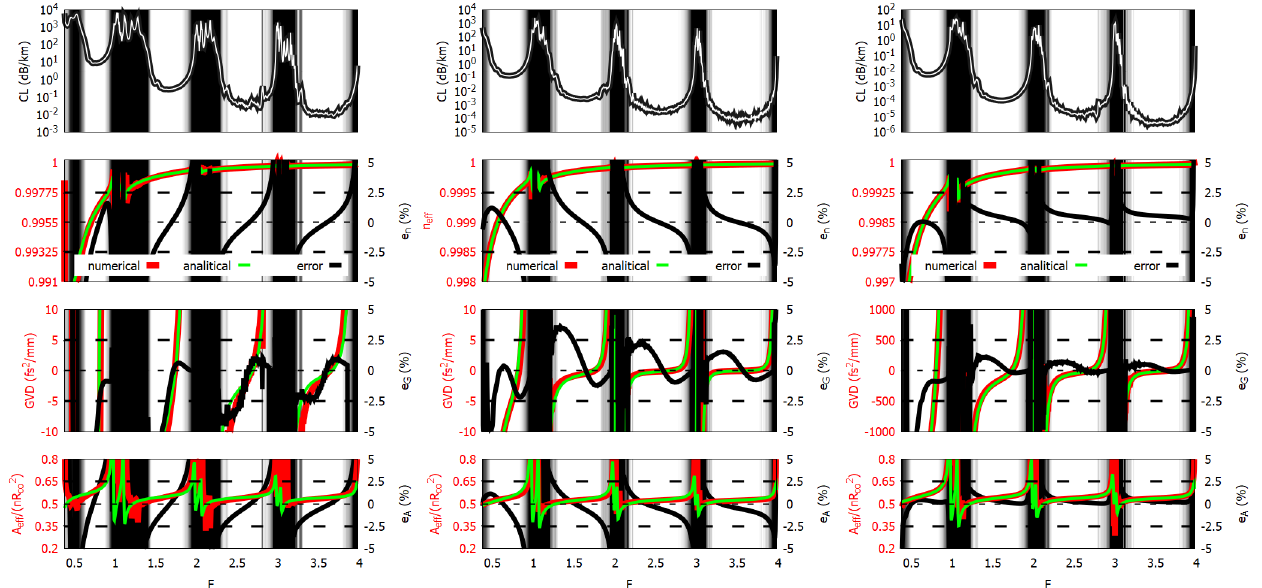
Figure 7. Confinement loss ( top row ), effective index ( top-central row ), group velocity dispersion ( bottom-central row ), and effective area ( bottom row ) of fibers F#8 ( left ), F#9 ( central ), and F#10 ( right ). Dark areas correspond to high loss regions. For effective index, group velocity dispersion, and effective area, solid green, red, and black curves show numerical and analytical result, and relative error,